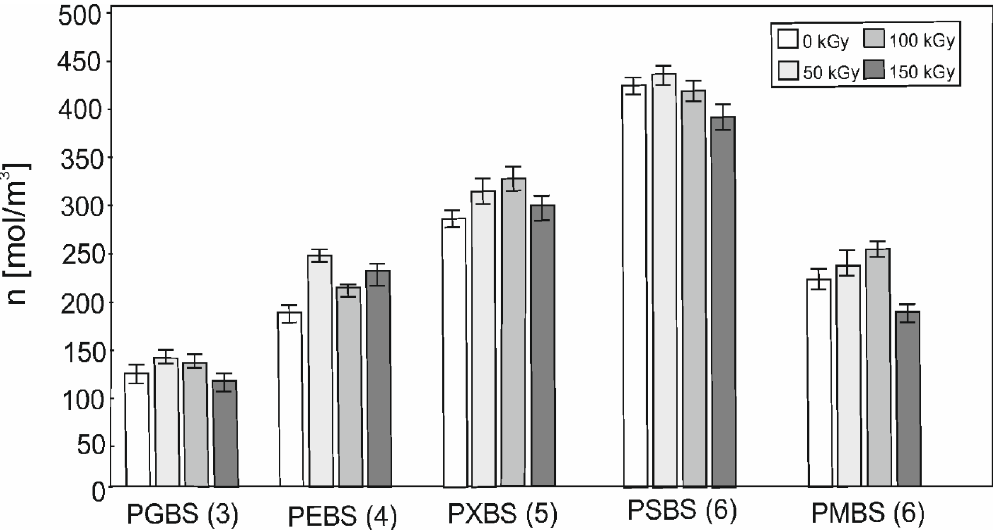
Figure 7. Crosslinking density of PGBS, PEBS, PXBS, PSBS, and PMBS before and after irradiation. Numbers in the brackets indicate the amount of hydroxyl groups in the sugar alcohols.